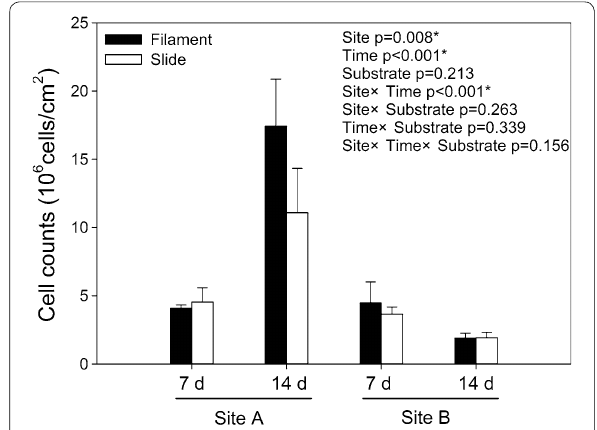
lentic, B lotic) and = =